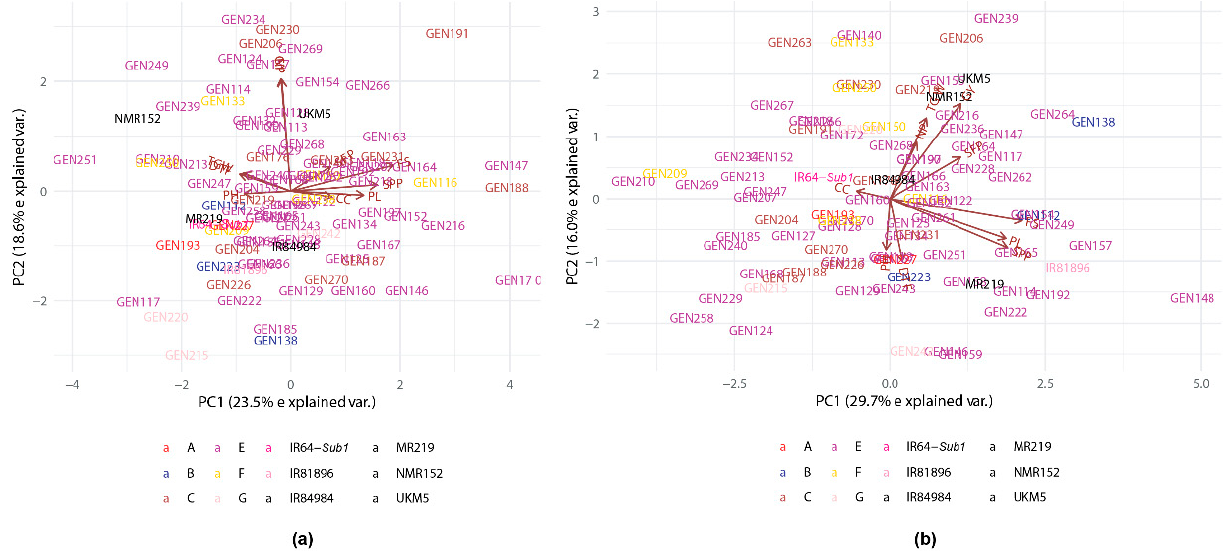
Figure 2. Principal component analysis biplot for 10 traits and 91 genotypes evaluated in ( a ) non-stress and ( b ) reproductive stage drought stress trials in 2019MS.